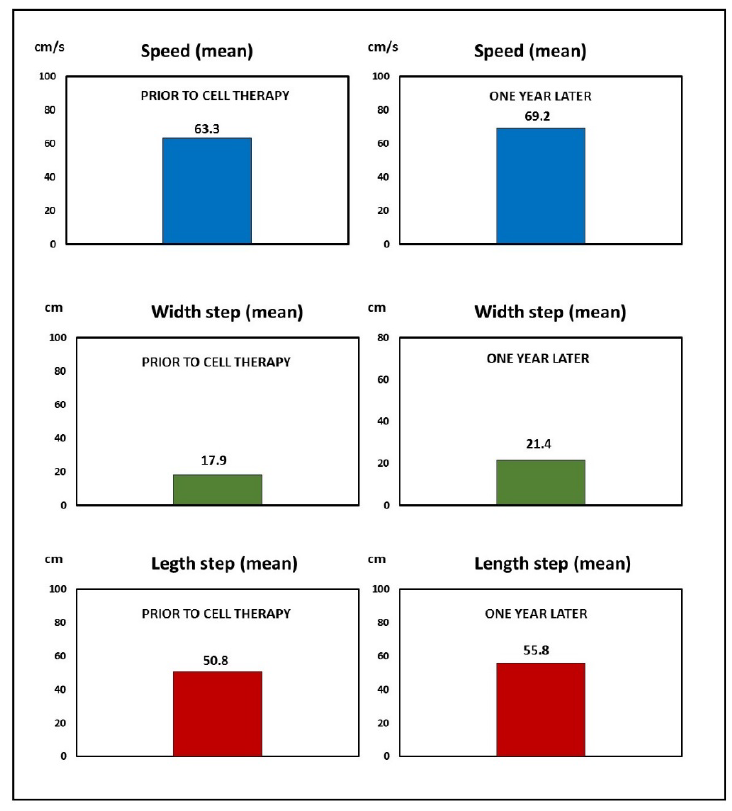
Figure 4. Case 2: Improvement obtained by cell therapy in the gait analysis.